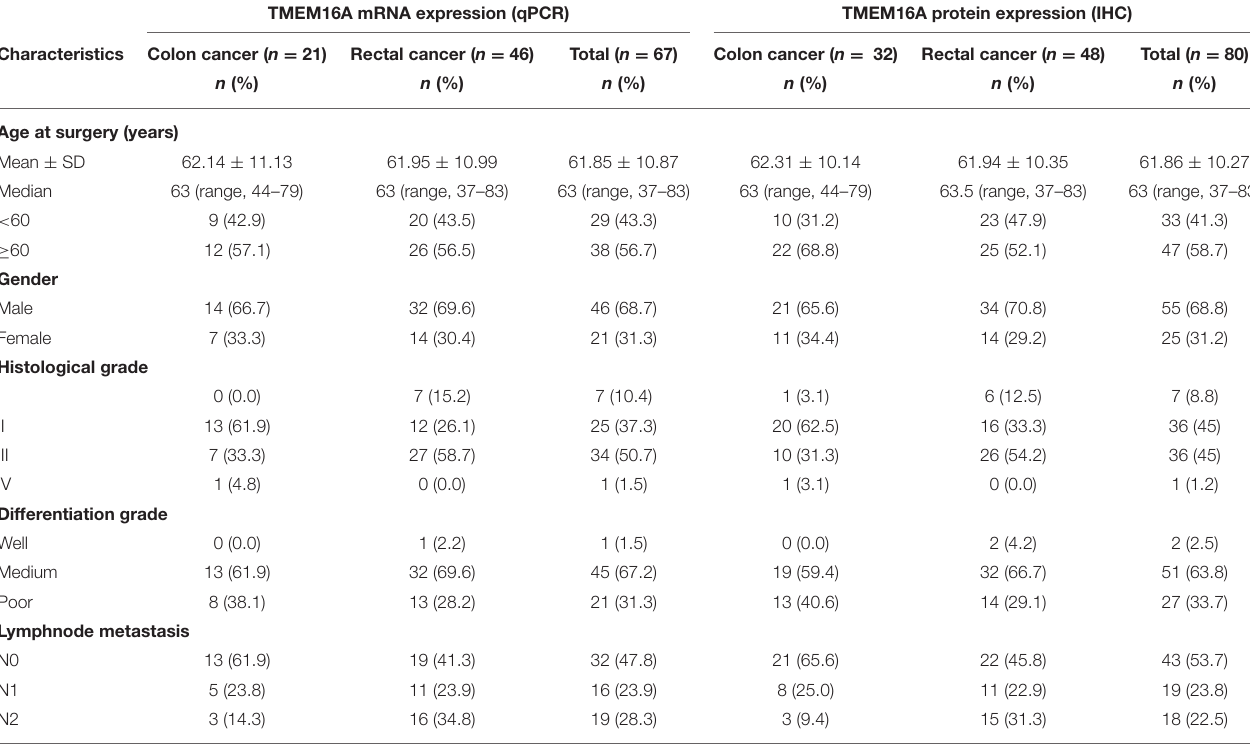
TABLE 1 | Clinicopathological characteristics of the CRC patients. TMEM16A mRNA expression (qPCR) TMEM16A protein expression